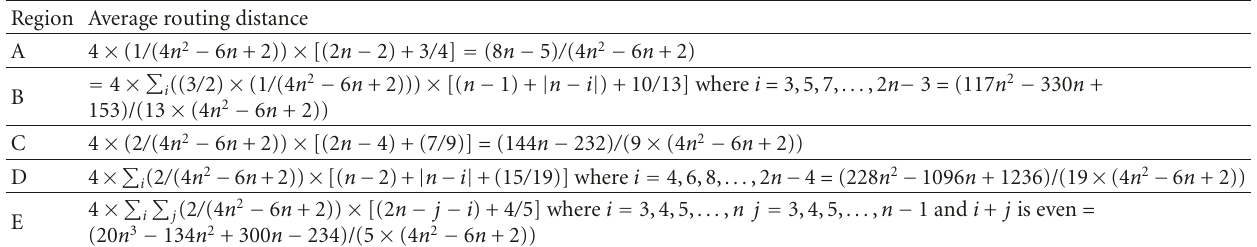
Table 1: Average routing distances derived by the regions where the THA is located. Region Average routing distance